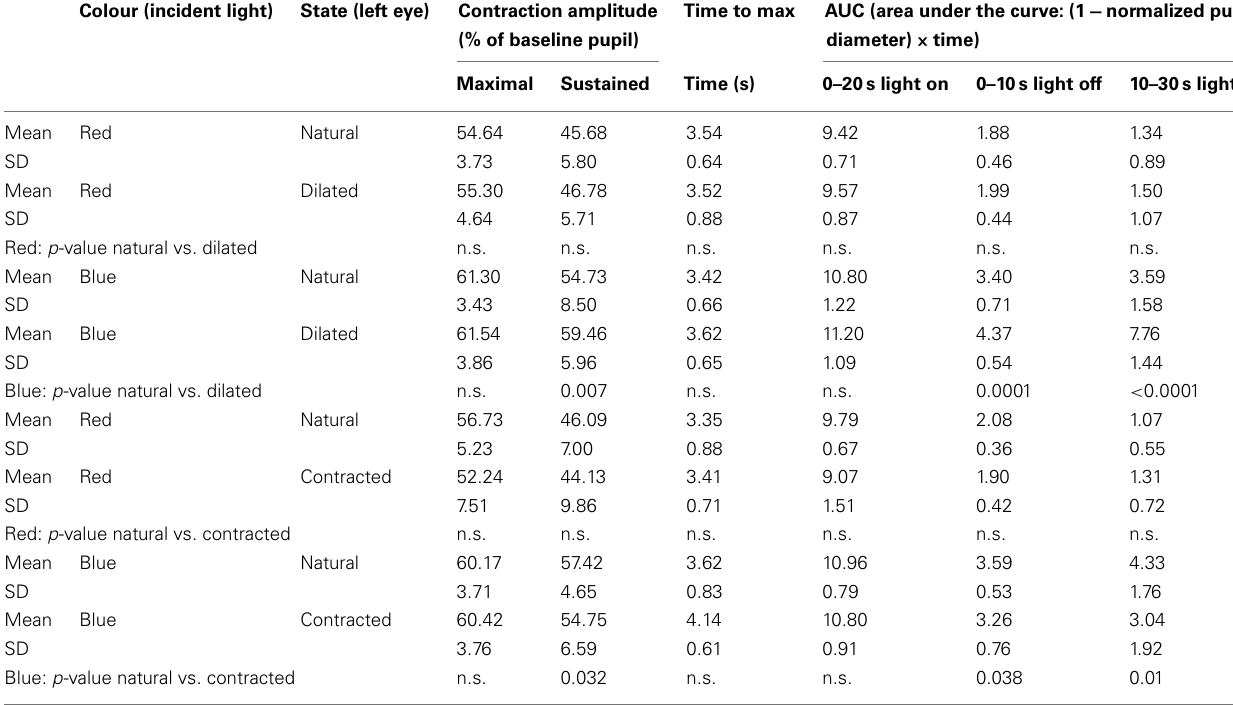
Table 1 | Response of the right pupil to exposure of the left pupil to either red or blue light. Colour (incident